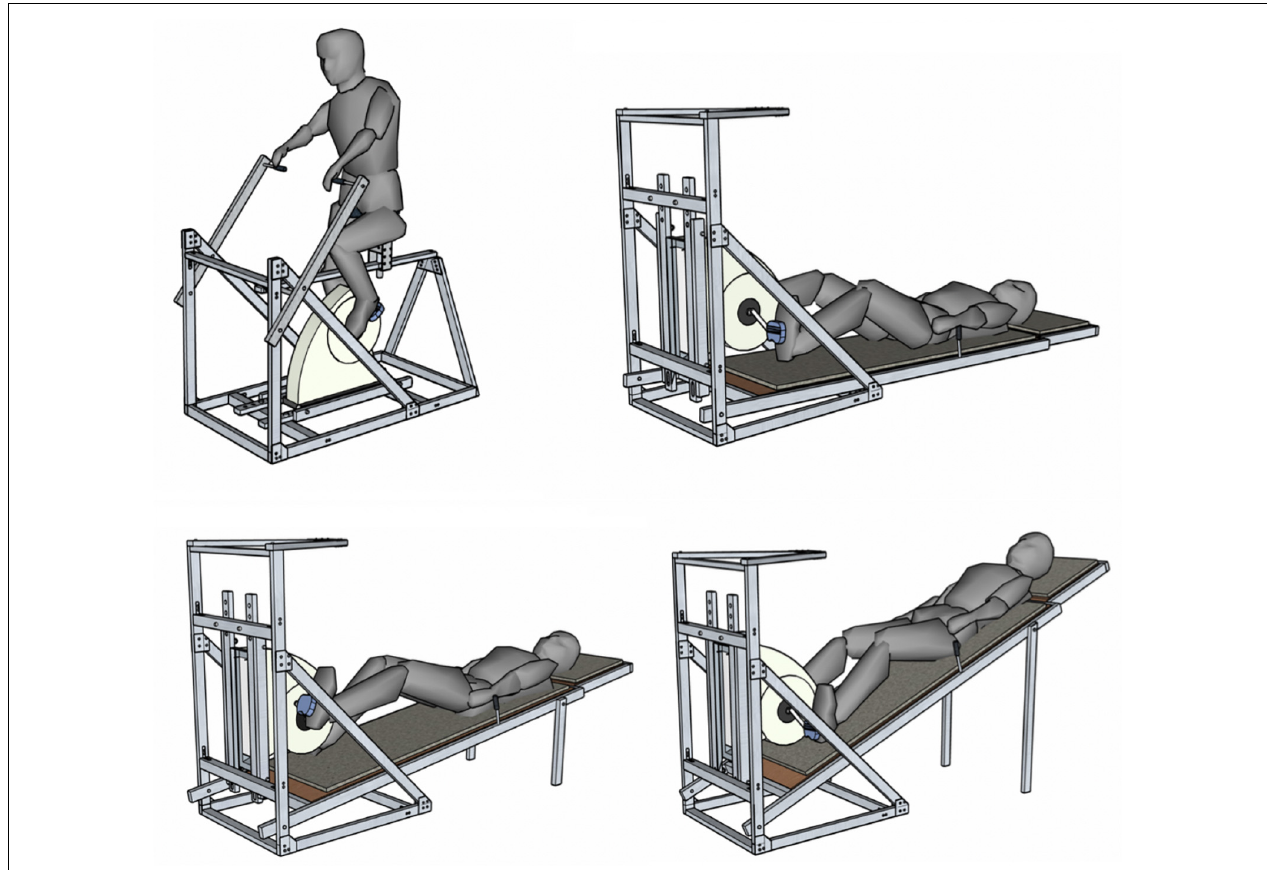
FIGURE 1 | The Altered-gravity Exercise Platform Simulator in upright-Earth configuration (upper left), − 6 ◦ HDT-Microgravity configuration (upper right), + 9.5 ◦ HUT-Moon configuration (bottom left), and + 22.3 ◦ HUT-Mars configuration (bottom right).